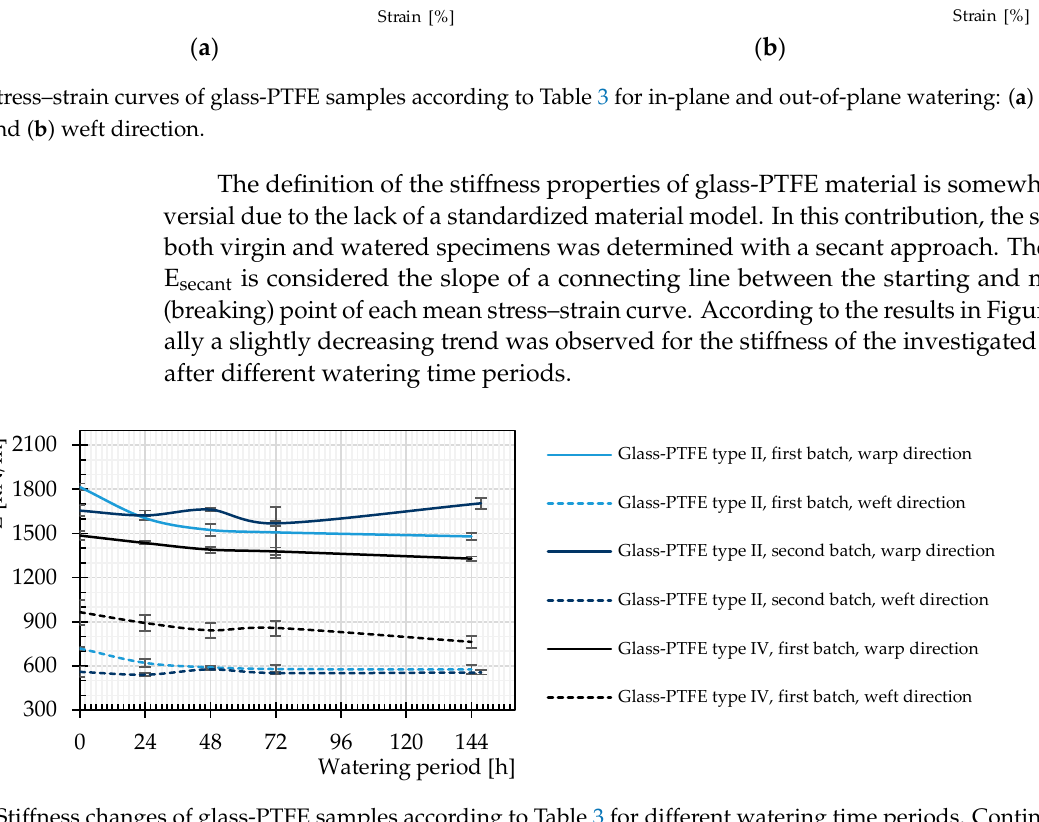
Figure 10. Stiffness changes of glass-PTFE samples according to Table 3 for different watering time periods. Continuous lines: warp direction, dashed lines: weft direction.